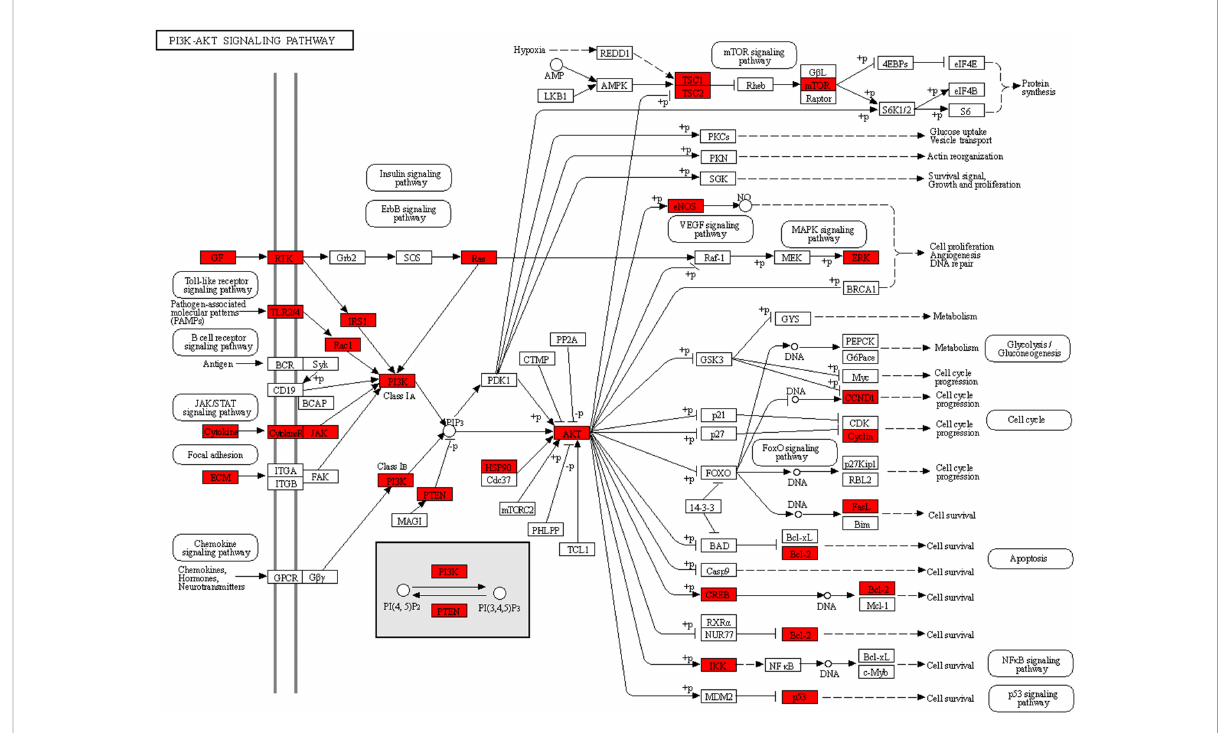
FIGURE 7 The risk genes for DKD with IBD are depicted in the PI3K-Akt signaling